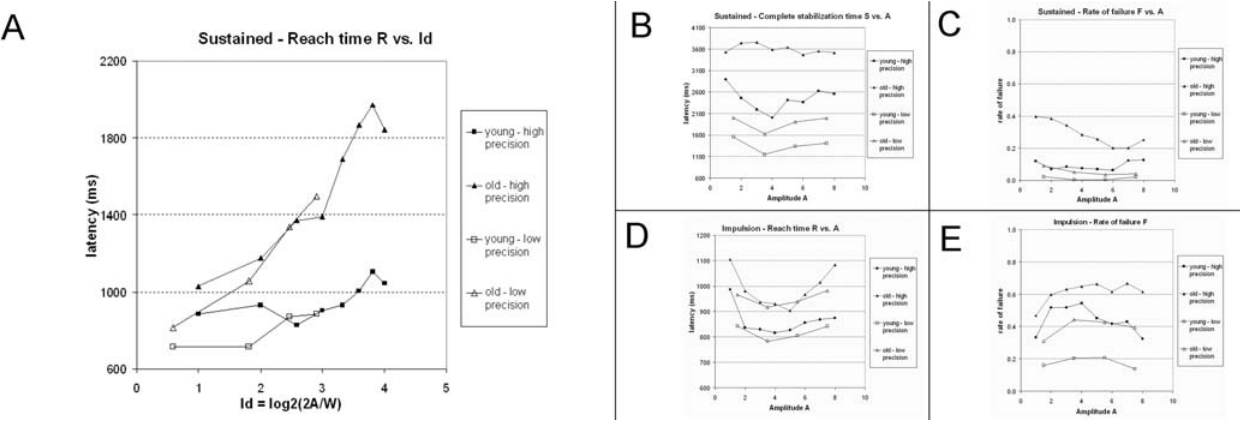
Figure 3. Performance indicators as functions of Amplitude and Precision. Each dot represents the average performance of one group (young, aged) for a combination of amplitude and precision. Each graph contains four curves, one per combination of Age and Precision. A : reach time R in the sustained modality. B : complete stabilization time S in the sustained modality. C : rate of failure F in the sustained modality. D : reach time R in the impulsion modality. E : rate of failure in the impulsion modality. Note that the horizontal scale for the reach time in the sustained modality ( A ) is Fitts’ index of difficulty Id=log 2 (2A/W). This depicts how the curves in high and low precision can be fitted by a regression line. For the remainder ( B, C, D, E ), the horizontal scale is the amplitude.